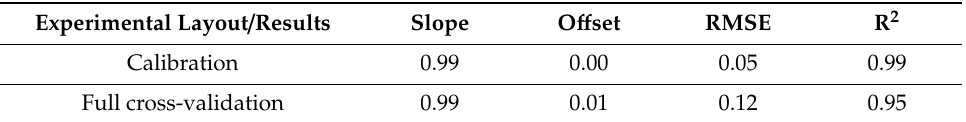
Table 3. The parameters of “measured vs. predicted” plots for PLS models predicting the sodium hypochlorite content from the multisensor system response.